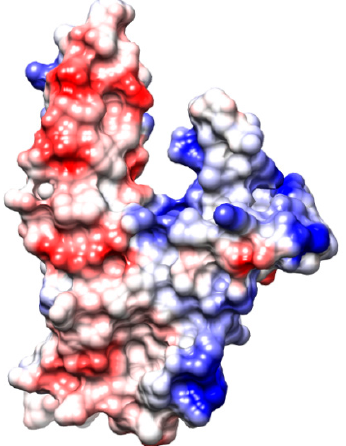
Figure 7. Schematic representation of RAD52 (1–212) monomer surface electrostatic potentials (PDB 1KN0). The representation was carried out using the Coulombic tool of UCSF Chimera, where − 10 was set as the minimum (red) and 10 was set as the maximum (blue).